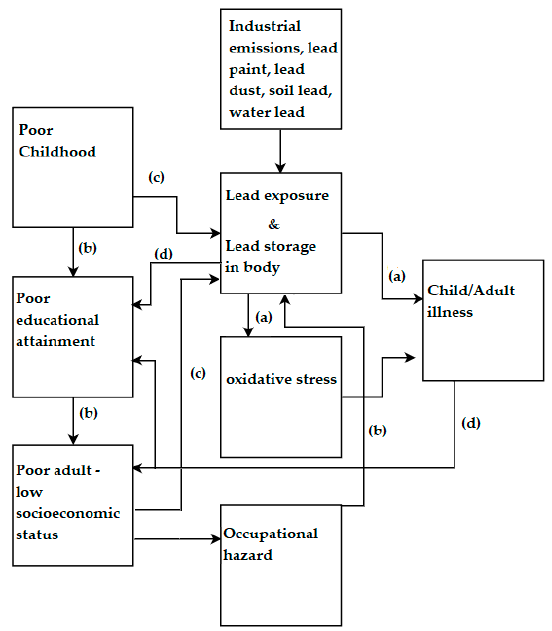
Figure 1. Schematic showing how lead exposure acts across the life course of an individual.